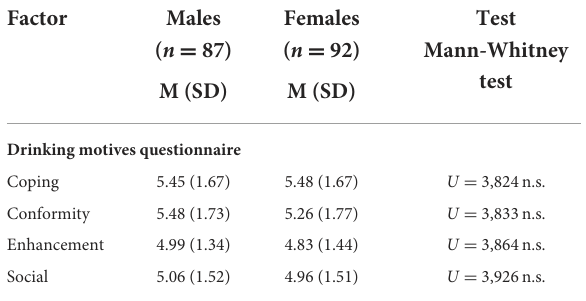
TABLE 2 Differences between male and female binge drinkers on drinking